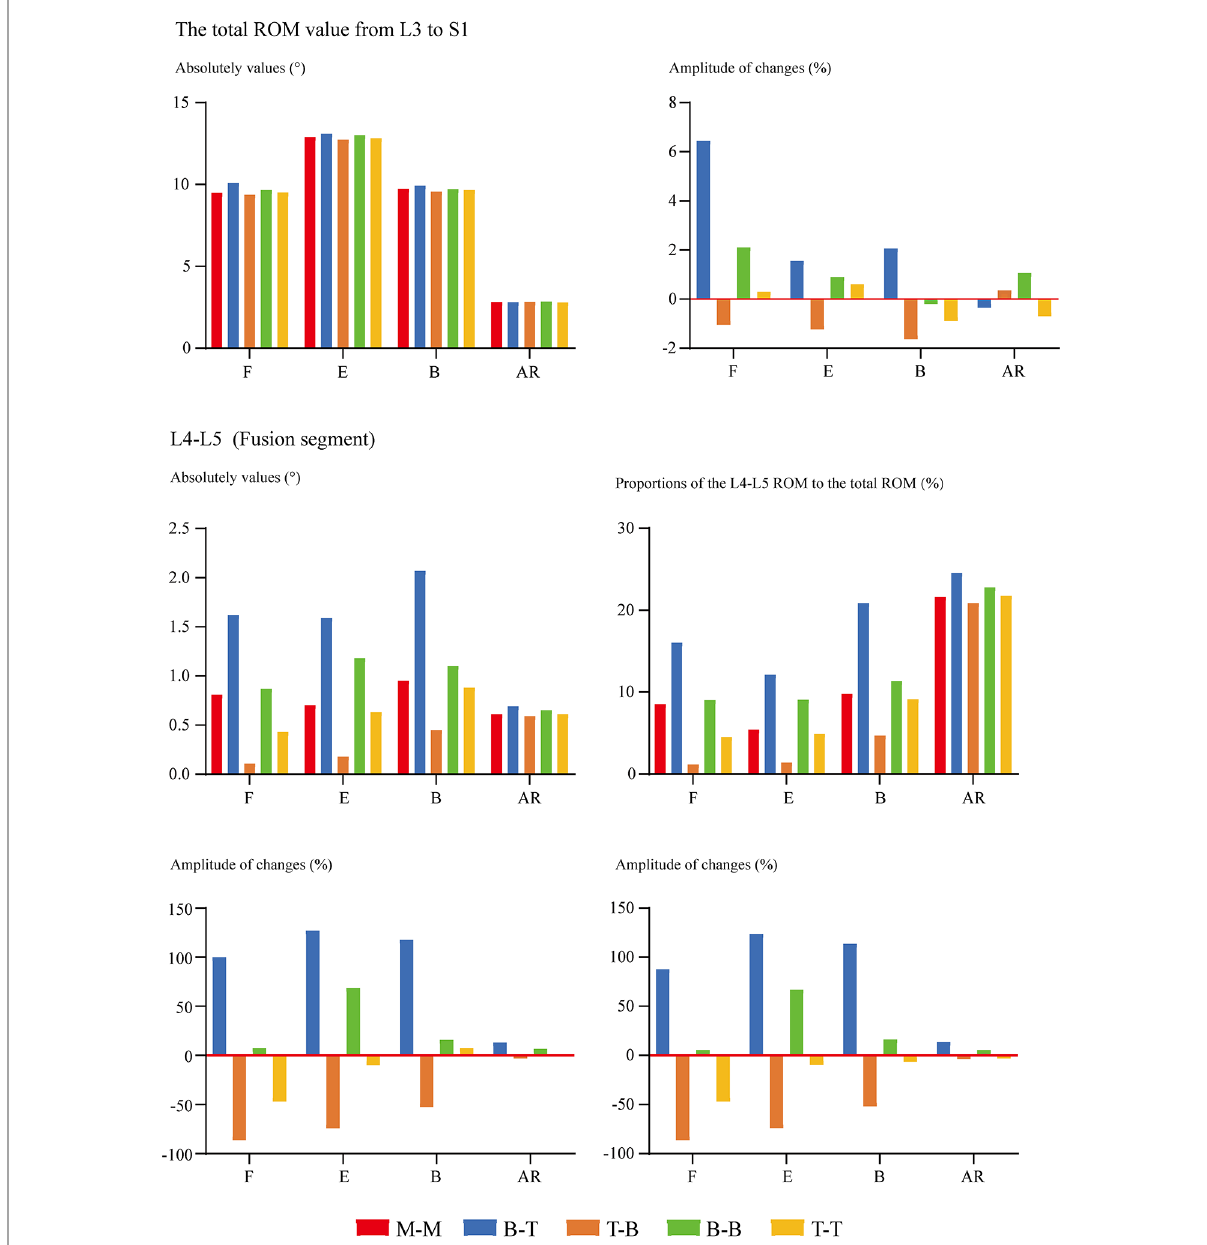
FIGURE 2 Comparison of overall and surgical segment ’ s ROM between surgical models with different insertional screw positions. F, Flexion; E, Extension; B, Bending; AR, Axial